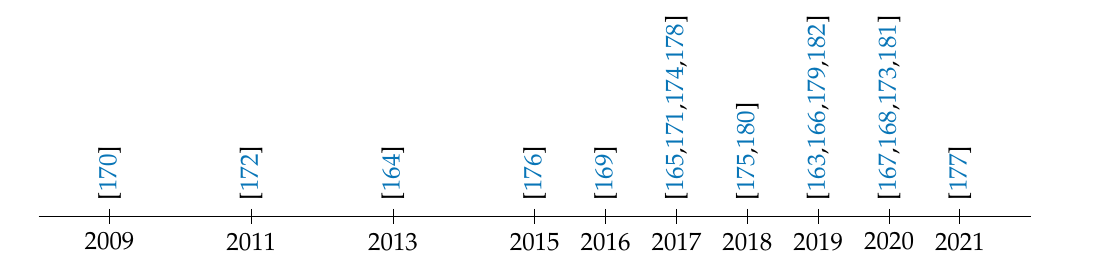
Figure 10. A timeline of different papers within the theoretical overviews of dark net privacy and security theme.